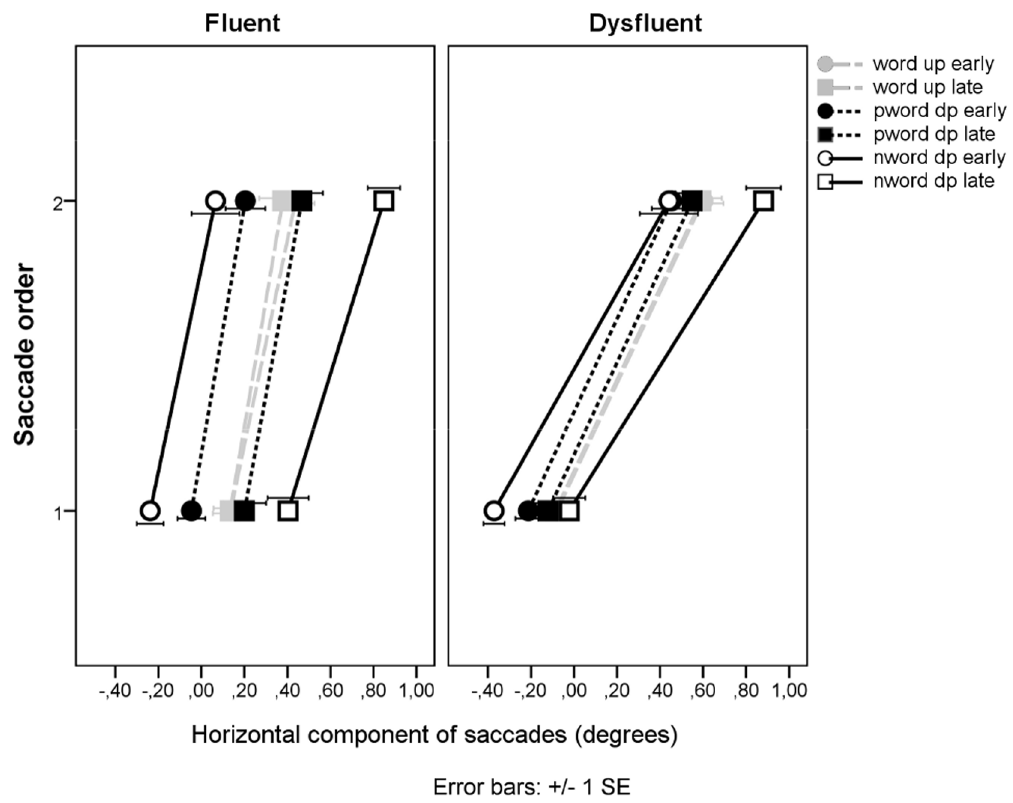
Figure 7. The horizontal movements of saccades.